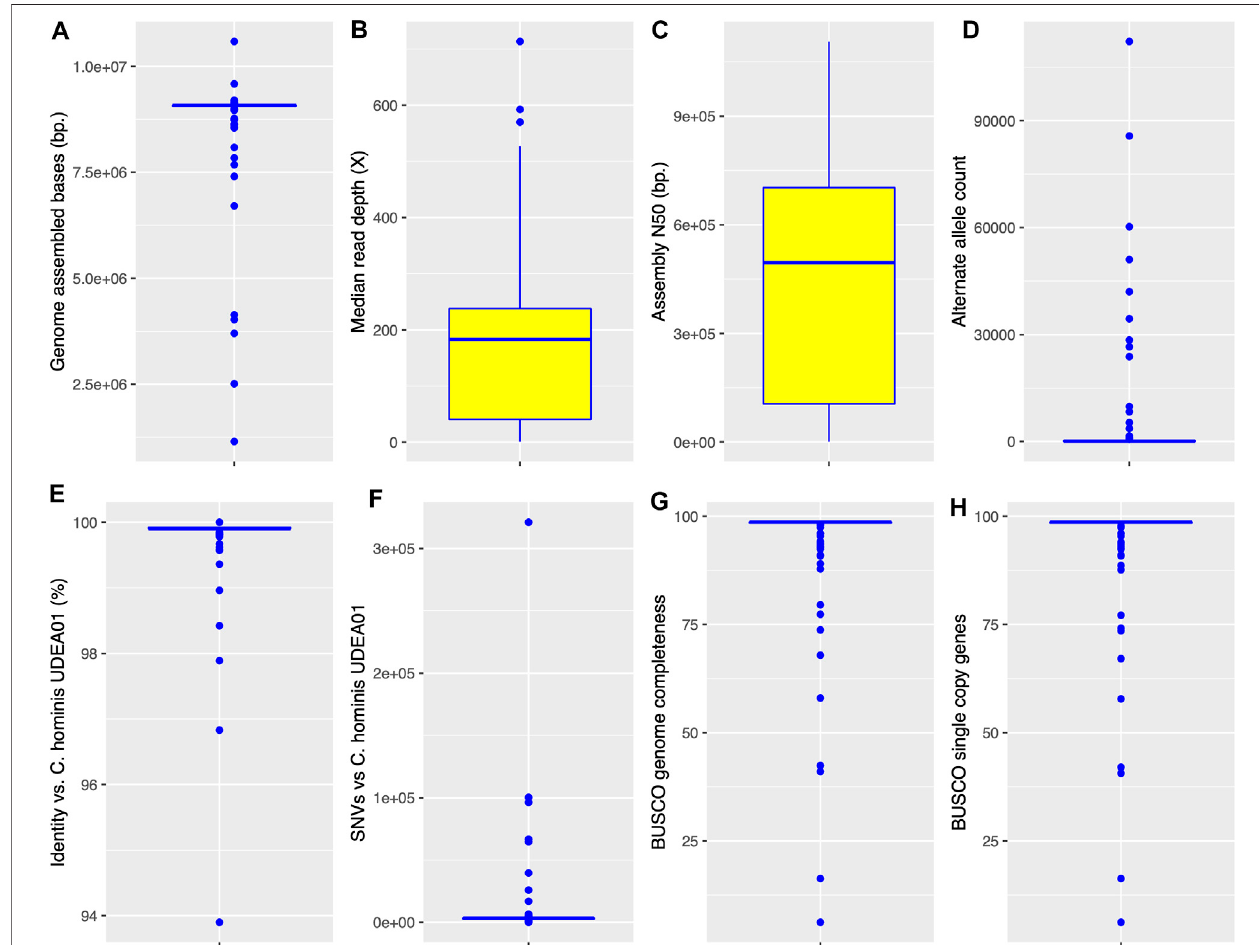
FIGURE 1 | Boxplots representing the descriptive statistics of the de novo assembled C. hominis genomes. The box represents the interquartile range, IQR 25th -75th percentile. The line represents the 50th percentile. Whiskers denote the 0th and 100th percentile. (A) Cryptosporidium genome assembled bases. (B) Scaffold median readdepth. (C) Cryptosporidium assemblyN50value. D .Scaffoldpositionswithanalternateallele. (E) Assemblygenomicnucleotideidentityagainst C.hominis UDEA01 reference. (F) Single nucleotide variants (SNVs) detected in each C. hominis assembly against C. hominis UDEA01 reference. (G) BUSCO genome completeness. (H) BUSCO single-copy